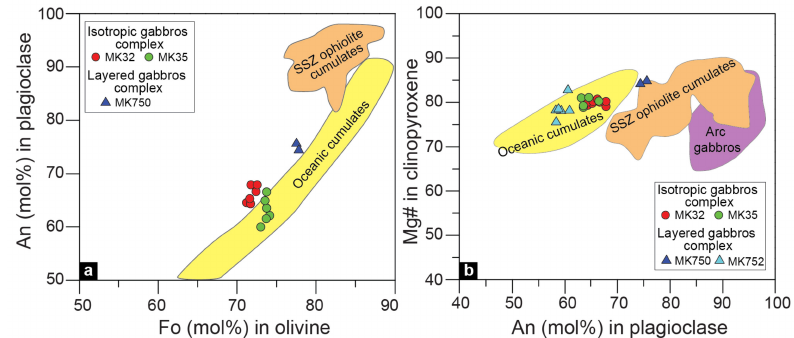
Figure 11. Forsterite (Fo) in olivine vs. Anorthite (An) in plagioclase ( a ) and Anorthite (An) in plagioclase vs. Mg# in clinopyroxene ( b ) diagrams for cumulitic gabbros from the layered and isotropic gabbro of the Band-e-Zeyarat ophiolite. Field for compositional variations of supra-subduction zone ophiolites, arc gabbros, and oceanic cumulate are shown for comparisons